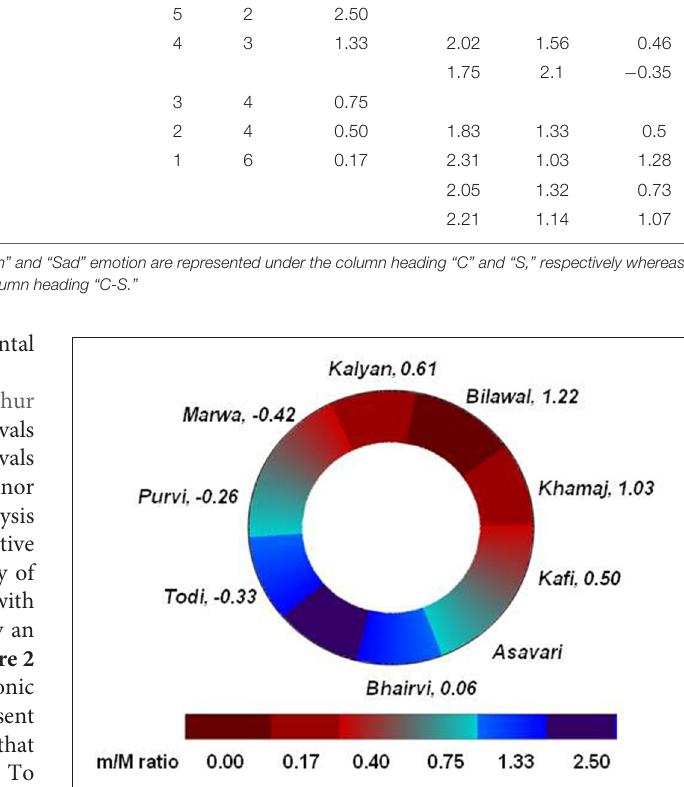
FIGURE 3 | Similarities between the tonal ratio (m/M) and valence of ragas when arranged along Circle of Thaats. The tonal ratio is color coded in increasing order on a scale of red to blue. Valence values associated with each thaat are indicated next to the names of the thaat , with negative valence preceded by the minus sign. For thaats where multiple ragas were included in Mathur et al. a mean valence was estimated based on the ratings in Table 2 .